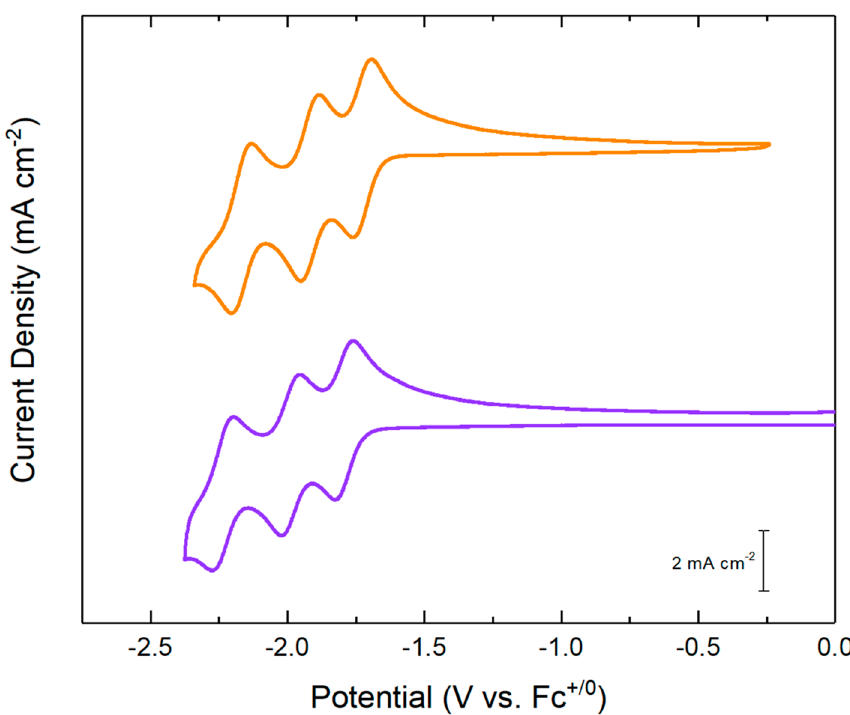
Figure 5. Cyclic voltammetry of 4 (orange) and 5 (purple) in MeCN solution with 0.1 M TBAPF 6 supporting electrolyte (working electrode: highly oriented pyrolytic graphite; pseudo-reference electrode: Ag +/ 0 ; counter electrode: Pt wire). Ferrocene was used as an internal potential reference.